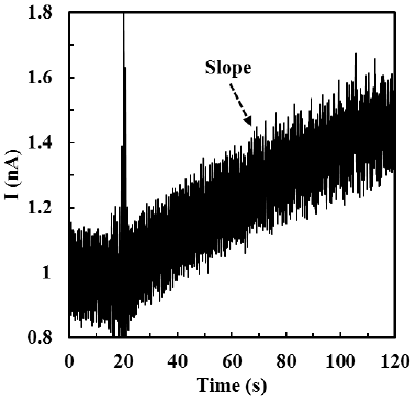
Figure 3. The typical I-t curve when testing ALT biosensors by Method 1 . The injection timing of the ALT solution is at 20 s.